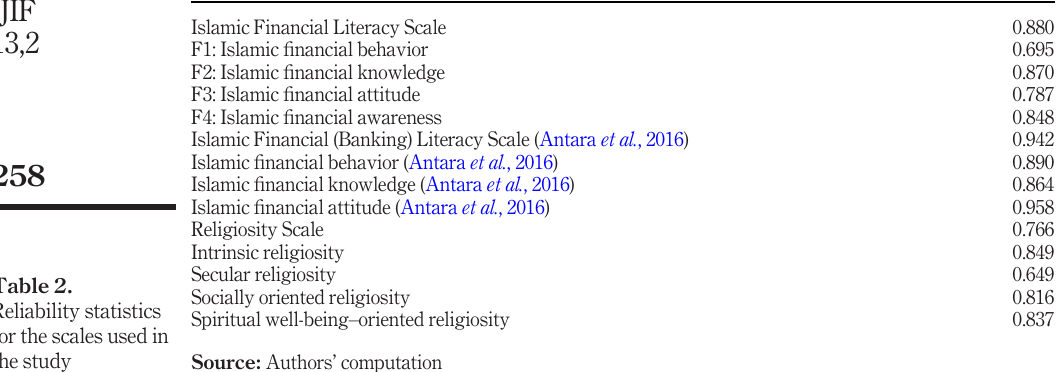
Table 2. Reliability statistics for the scales used in the study